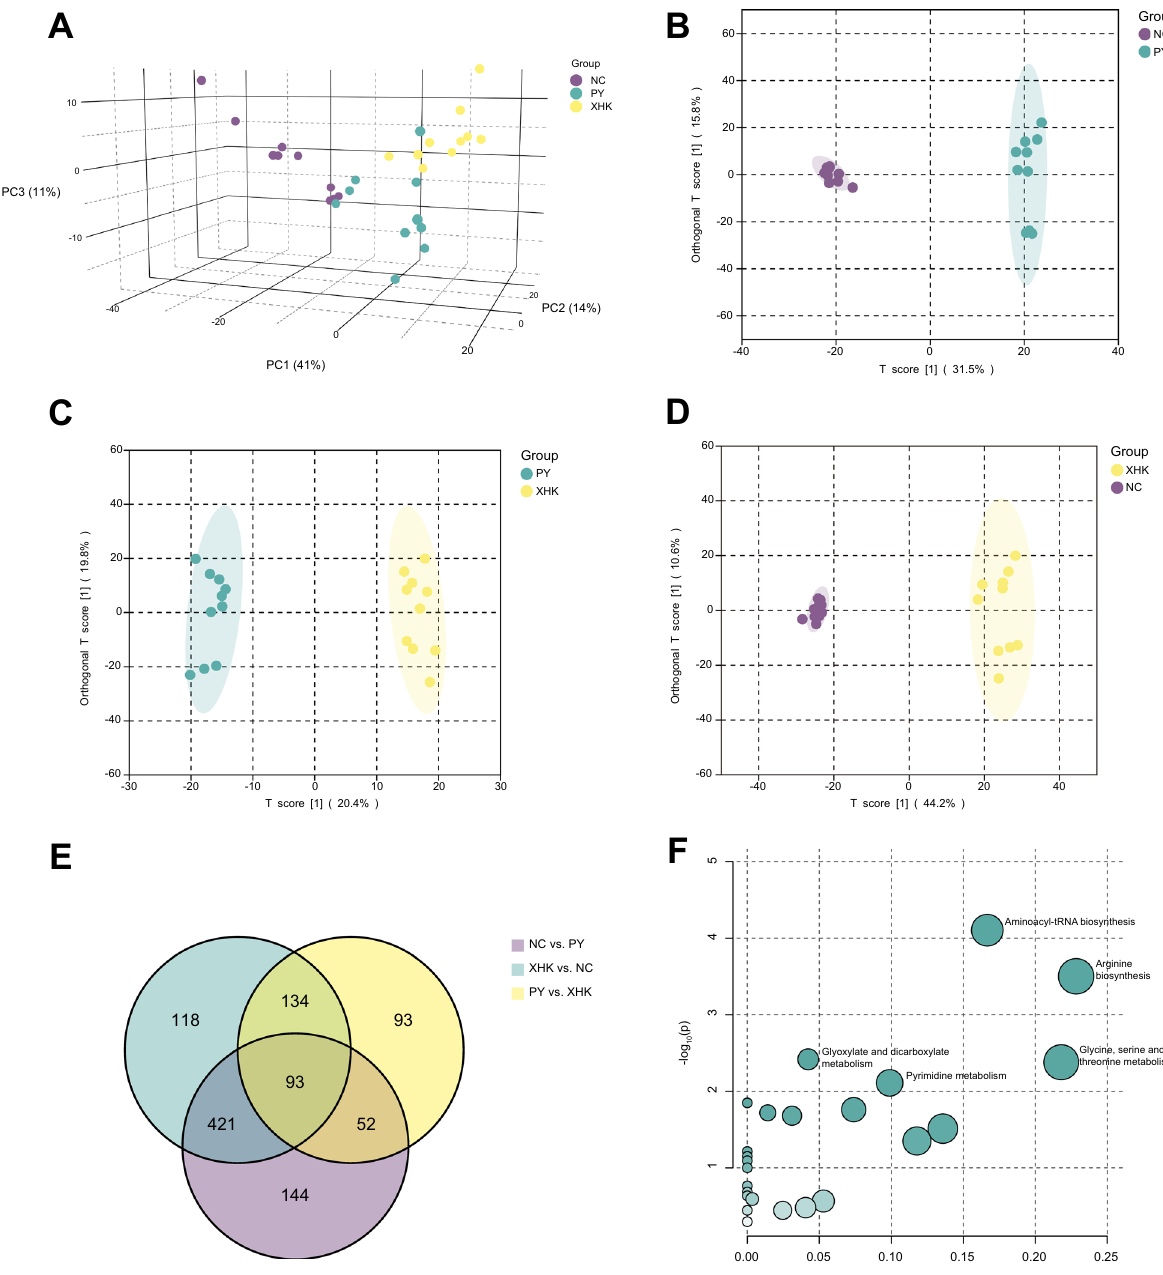
Fig. 3 Multivariate statistical analysis and metabolic pathway analysis of intestinal contents. A The PCA score plot clearly separates NC, PY, and XHK, indicating different metabolic profiles among the three groups. B – D The OPLS-DA score plots show a clear separation of every two groups, indicating strong effects of the culture systems on the metabolic composition. E The Venn diagram shows the number of significantly differential metabolites between groups, with the numbers in circles indicating the number of metabolites and the numbers in overlapping parts representing the number of common metabolites in intergroup comparison. F The enriched pathways are shown on a scatter plot, with the horizontal axis indicating the impact of the pathways and the vertical axis indicating the significance of the pathways. The significance and impact of each pathway are represented by the size and colour of the scatter,